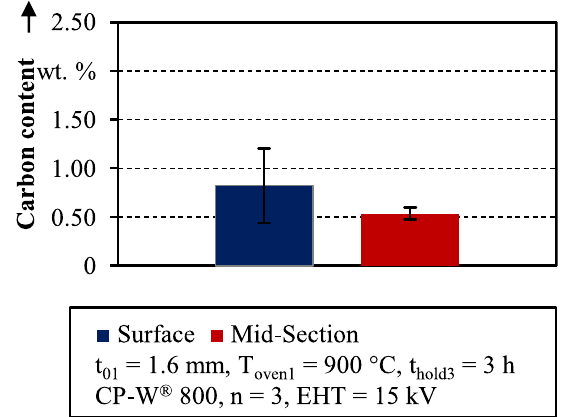
Fig. 13. Carbon content of sample with a sheet thickness of 1.6mm carburized for three hours at 900 ° C measured via